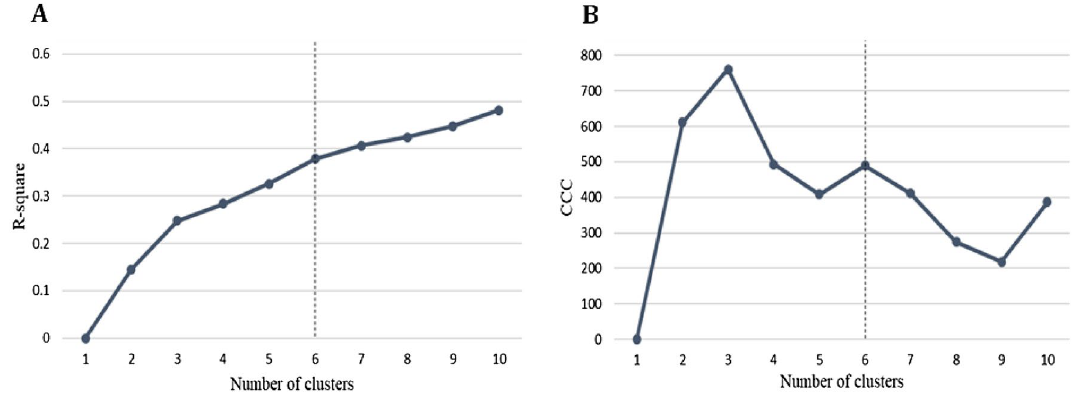
Figure 1. Scree plots for the K-means cluster analysis of study patients with polypharmacy. The elbow method was performed to determine the optimal number of clusters by estimating the ( A ) R-squared value and ( B ) CCC according to the number of clusters. The analysis used variables including sex, age, type of medical coverage, income level, disability, number of outpatient visits or hospitalization days per year, and number of visited medical institutes per year. These plots indicate that K = 6 is the optimal number of clusters in this study. CCC cubic clustering